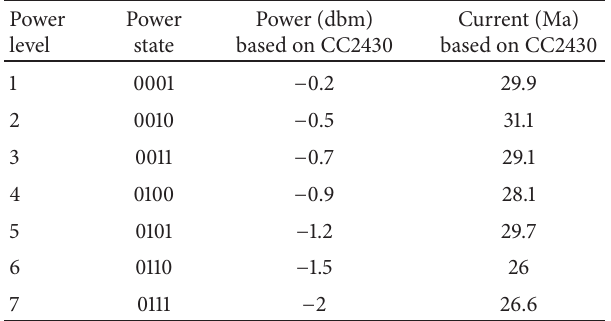
Table 3: Discrete power levels of CC2430 [18] with power state variable.